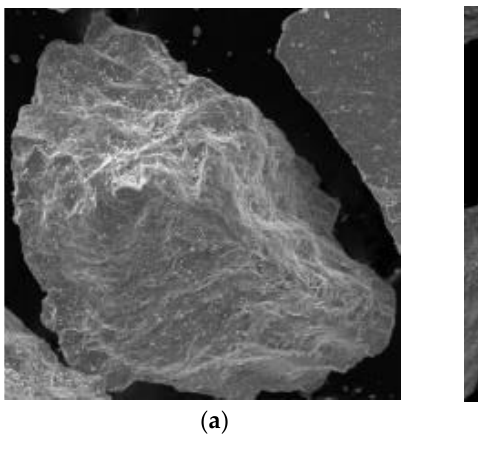
Figure 3. Morphology of polyhedral particles of VT20 alloy powder for different fractions: ( a ) 200–250 µ m, ( b ) 160–200 µ m, ( c ) 100–160 µ m.